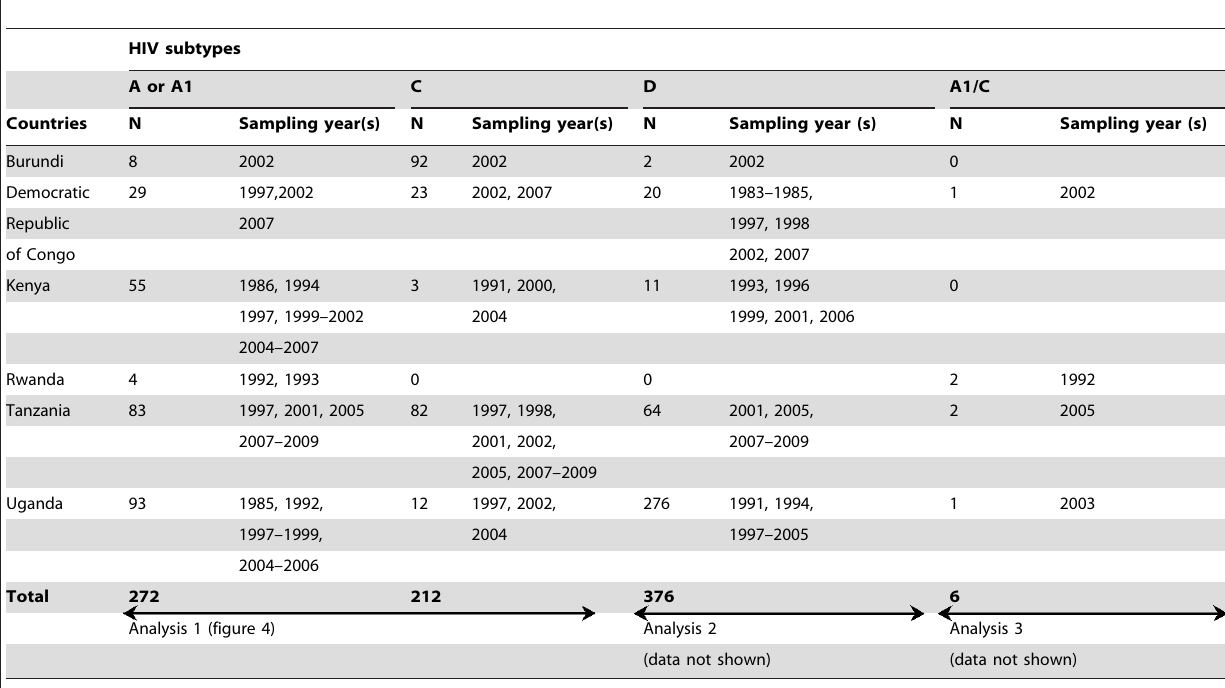
Table 2. Reference pol sequences from the Los Alamos database included in the phylogenetic analyses.